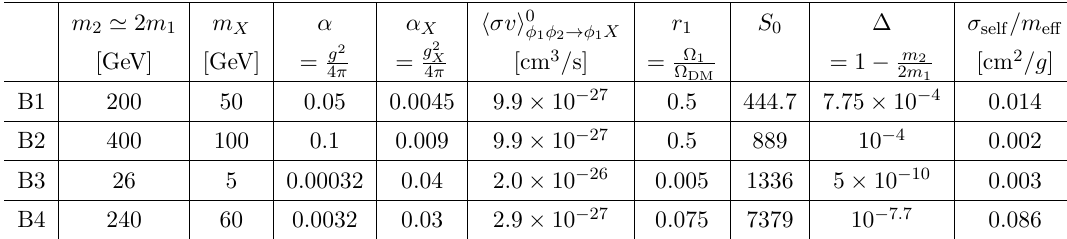
Table 2 . Benchmark models and constraints on Sommerfeld